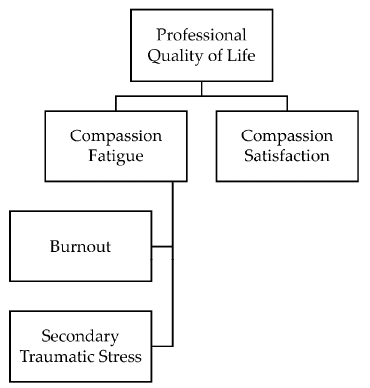
Figure 3. Professional Quality of Life Framework.